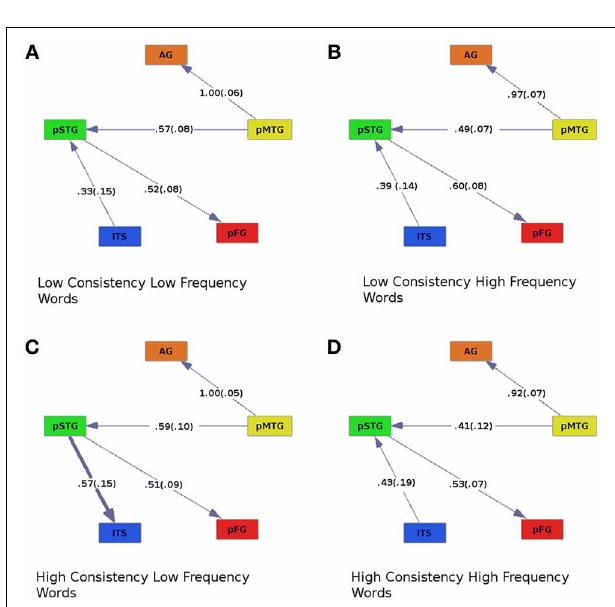
FIGURE 3 | Effective connectivity results for high (C,D) and low (A,B) levels of consistency crossed with high (B,D) and low (A,C) levels of word frequency. Colors are as in previous figures, and numbers are as in Figure 2 .